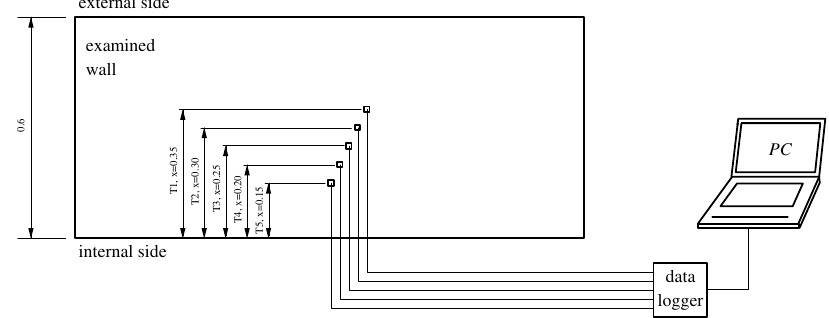
Figure 2. Experimental stand for temperature measurement inside the